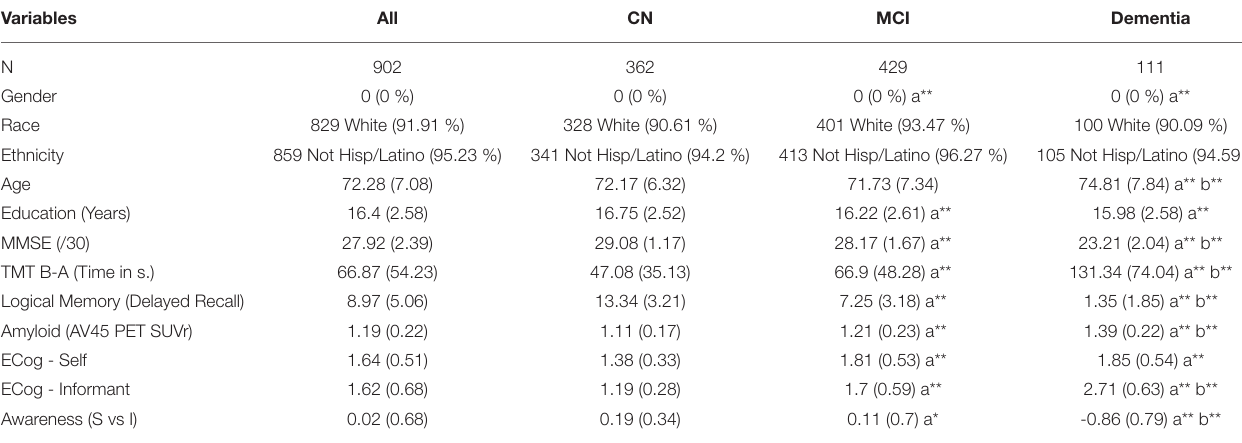
TABLE 1 | Demographic data and group